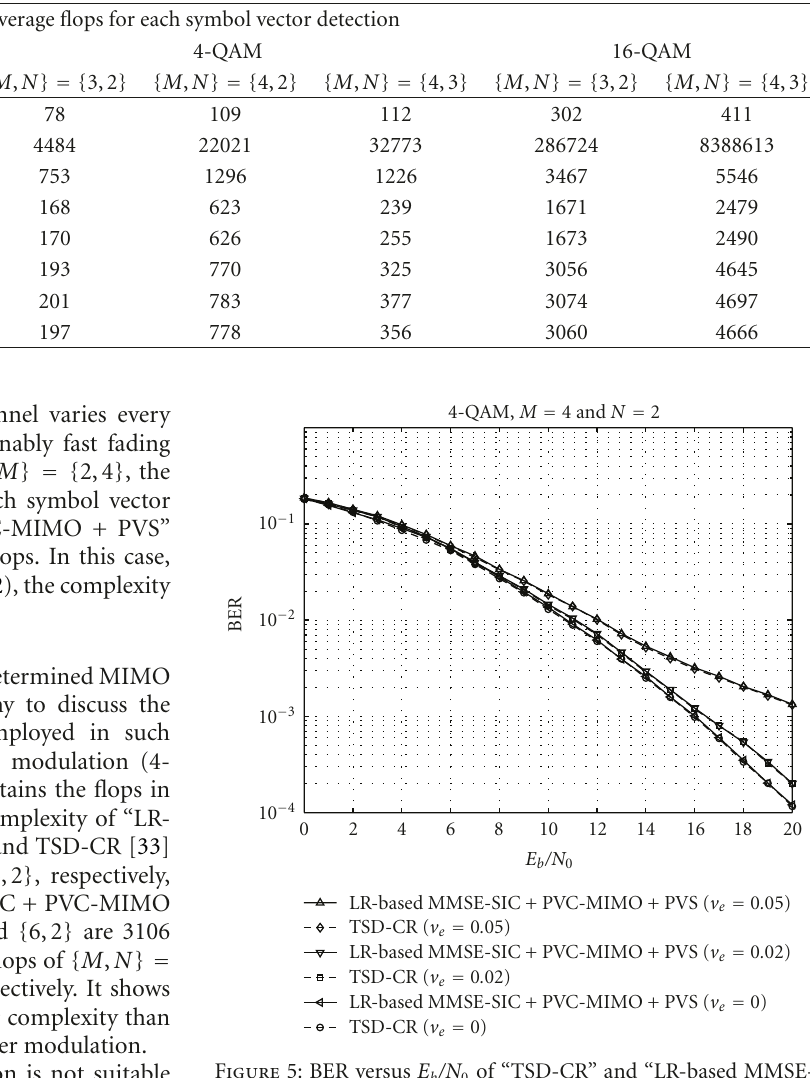
Figure 5: BER versus E b /N 0 of “TSD-CR” and “LR-based MMSE- SIC + PVC-MIMO + PVS” represented in Section 5.1 for v e = { 0,0 . 02,0 . 05 } with 4-QAM, M = 4, N = 2.